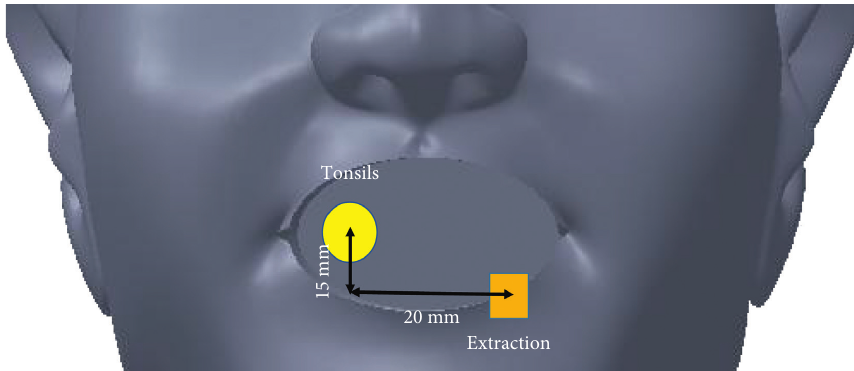
Figure 4: Schematic diagram of the relative position of the tonsil gland and the illuminating